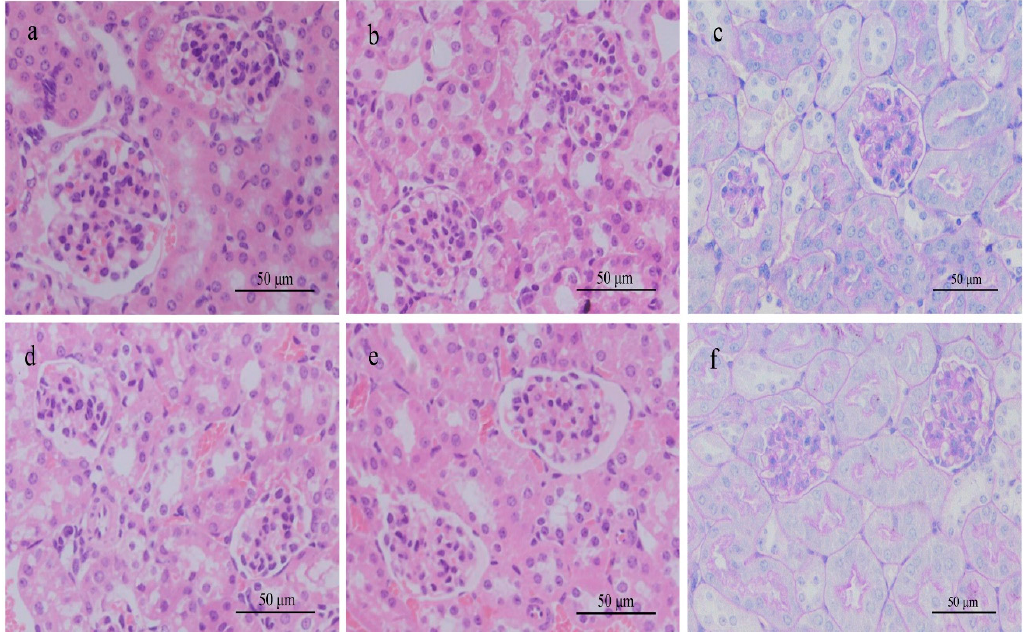
Figure 5. Kidneys of mice exposed to different concentrations of MC-RR for 28 days. ( a ) H & E stained histological section for 0.0 μ g/kg MC-RR. ( b ) H & E stained histological section for 140.0 μ g/kg MC-RR. ( d ) H & E stained histological section for 70.0 μ g/kg MC-RR. ( e ) H & E stained histological section for 35.0 μ g/kg MC-RR. ( c ) PAS-stained histological section for 0.0 μ g/kg MC-RR. ( f ) PAS-stained histological section for 140.0 μ g/kg MC-RR.